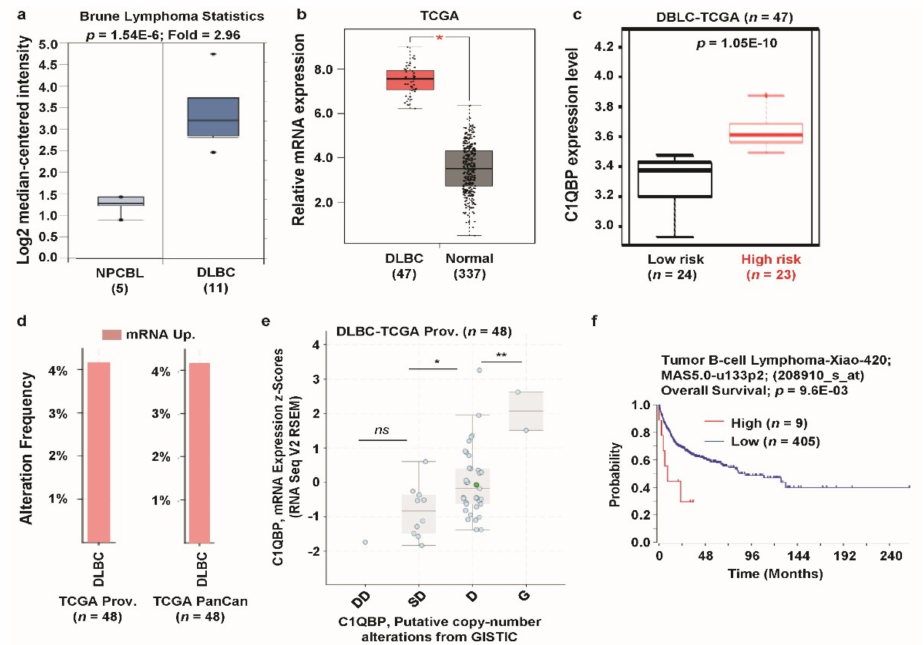
Figure 6. C1QBP expression pattern and patient survival analysis in lymphoma as compared to C1QBP expression in normal tissue and cancer tissue. ( a ) The fold-change of C1QBP in lymphoma was identified by our analyses, shown as a box plot. The box plot comparing specific C1QBP expression in normal ( n = 5, left plot) and cancer tissue ( n = 11, right plot) was derived from the Oncomine database. The analysis was shown in lymphoma relative to in normal tissue. The asterisk above and below the box represent maximum and minimum value, respectively. ( b ) Expression of the C1QBP gene in The Cancer Genome Atlas (TCGA) database. Box plots showing the C1QBP mRNA expression in DLBC (red plot) and their normal (blue plot) tissues, using data from the TCGA database through GEPIA. *: p < 0.01. ( c ) C1QBP gene expression in DLBC patients from the TCGA database. The box-plots generated using SurvExpress biomarker validation tool showing the gene expression in DLBC patients using cohorts from datasets generated by TCGA ( n = 47). Box-plots show expression levels and p -values resulting from the t -test of the difference expression between high risk (red) and low risk (green) groups in DLBC patients. ( d ) Alterations (mRNA upregulation) of C1QBP gene in DLBC (TCGA Prov., n = 48; TCGA PanCan atlas, n = 48). Data was obtained using cBioPortal. ( e ) C1QBP mRNA expression was significantly